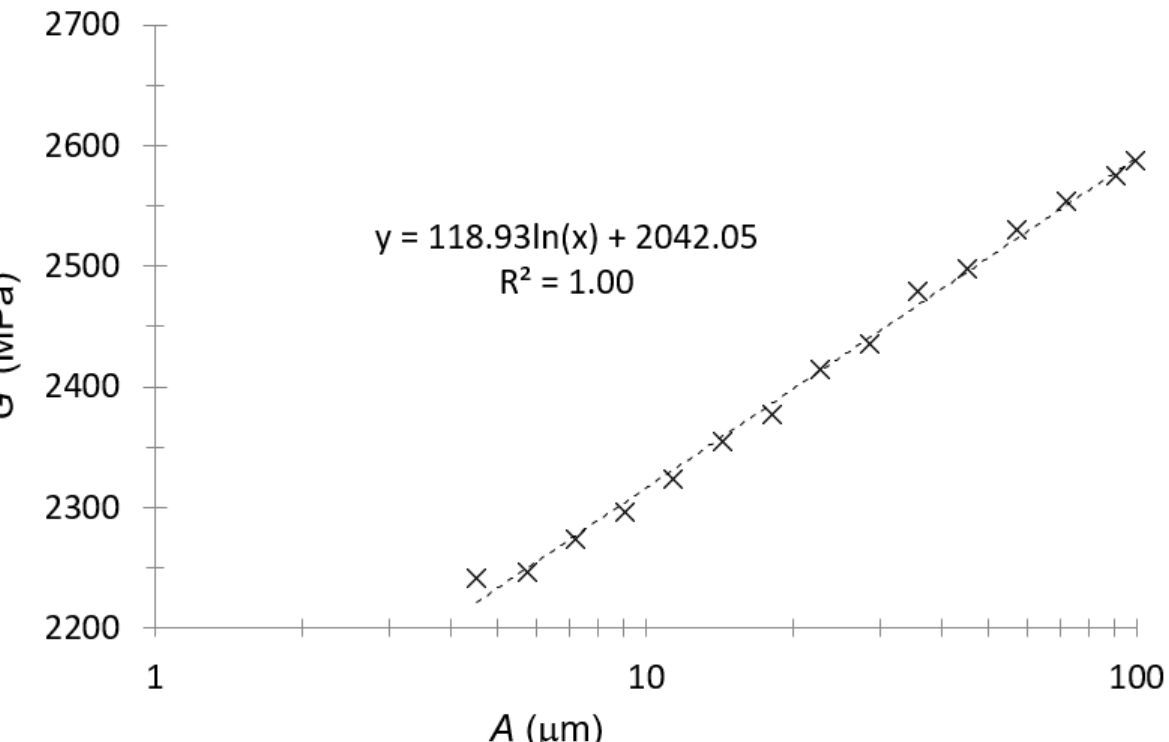
Figure 2. Storage modulus–amplitude plot for PA66.